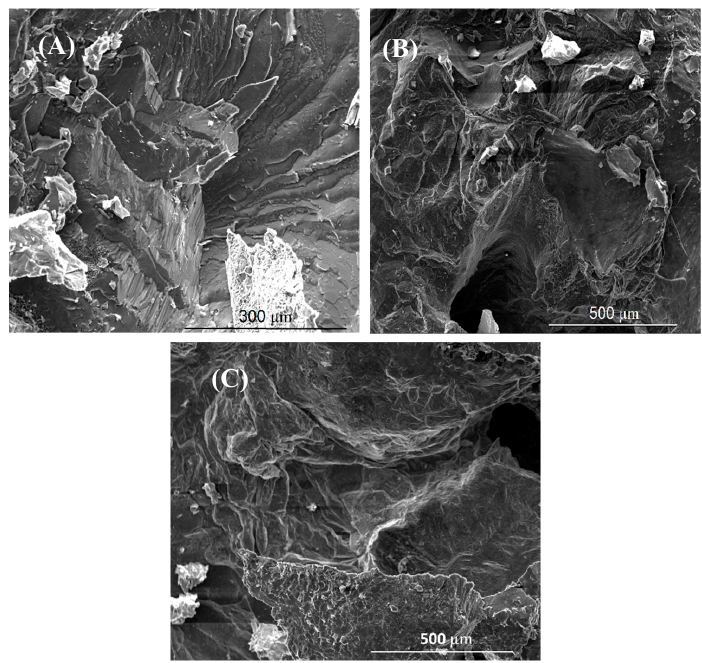
Figure 15. SEM images of the fracture surfaces for joints bonded with Cu/Al 2 O 3 for ( A ) 2 min, ( B ) 5 min and ( C ) 10 min.